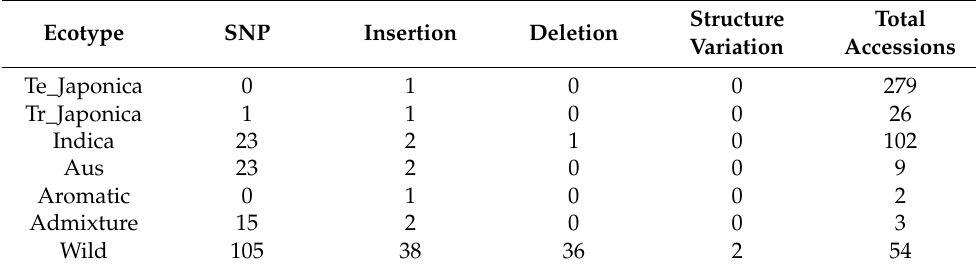
Structure Total Variation Accessions